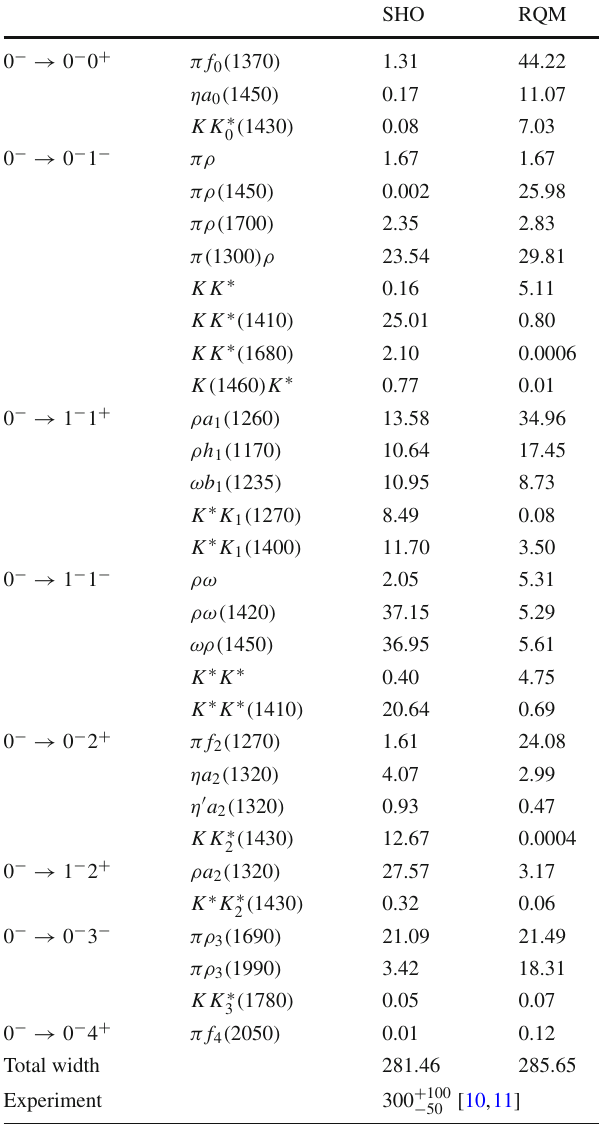
Table 2 Decay widths of the π( 2360 ) as the π( 5 1 S 0 ) with two types of wave functions (in MeV). The initial state mass is set to 2360 MeV Channel